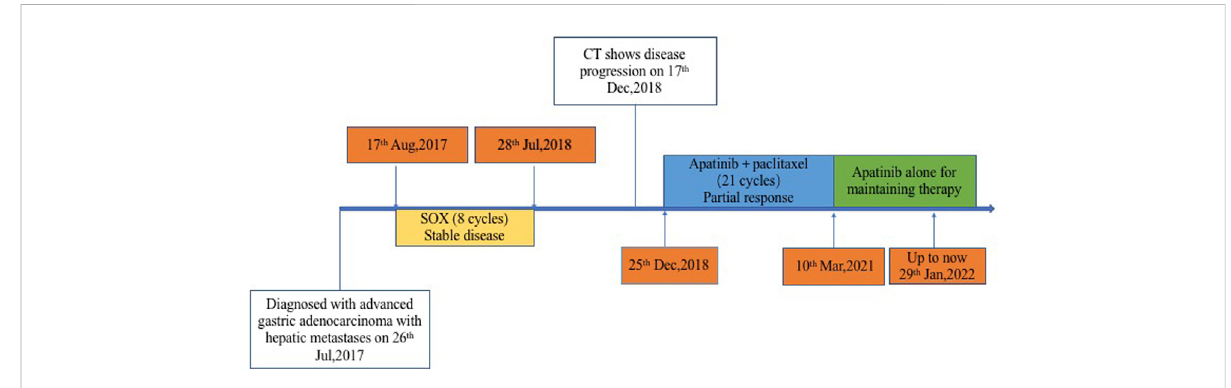
FIGURE 3 Timeline of management of this patient with metastatic gastric